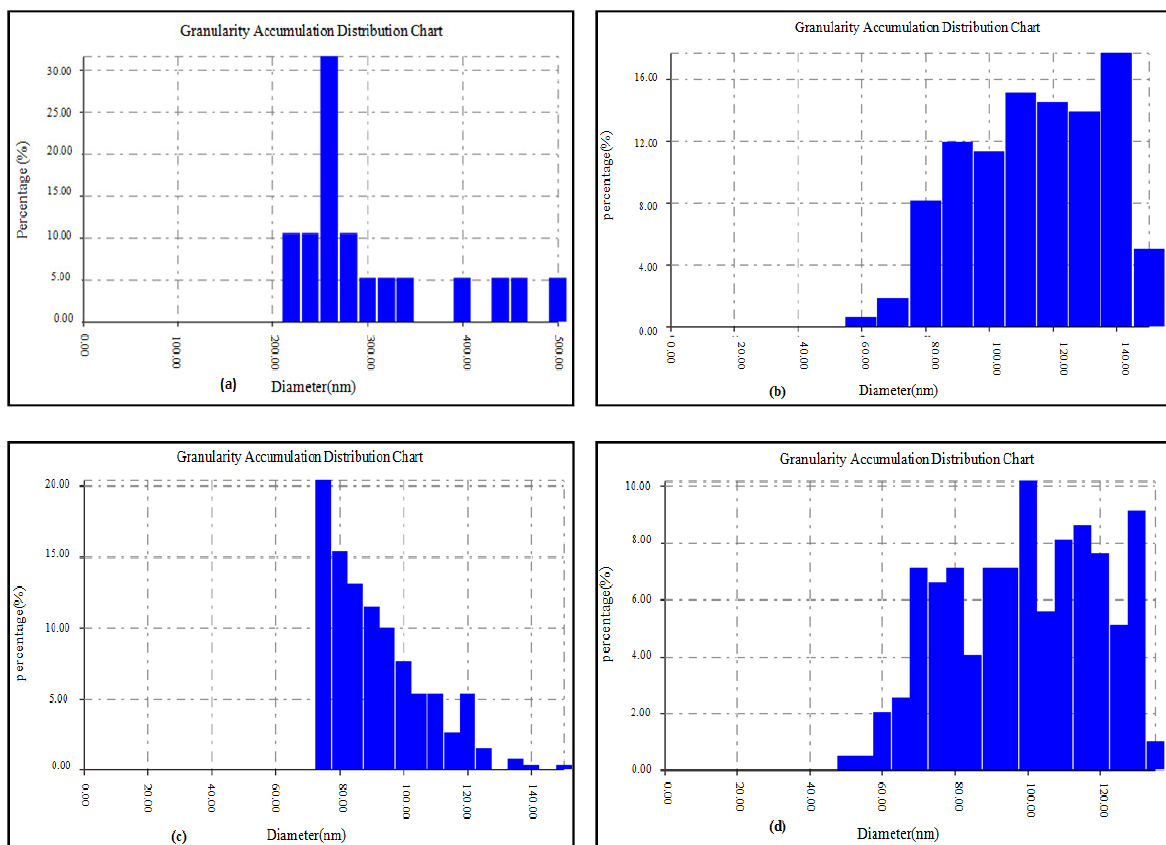
Fig. (9) shows granularity accumulation distribution charts for different samples, these